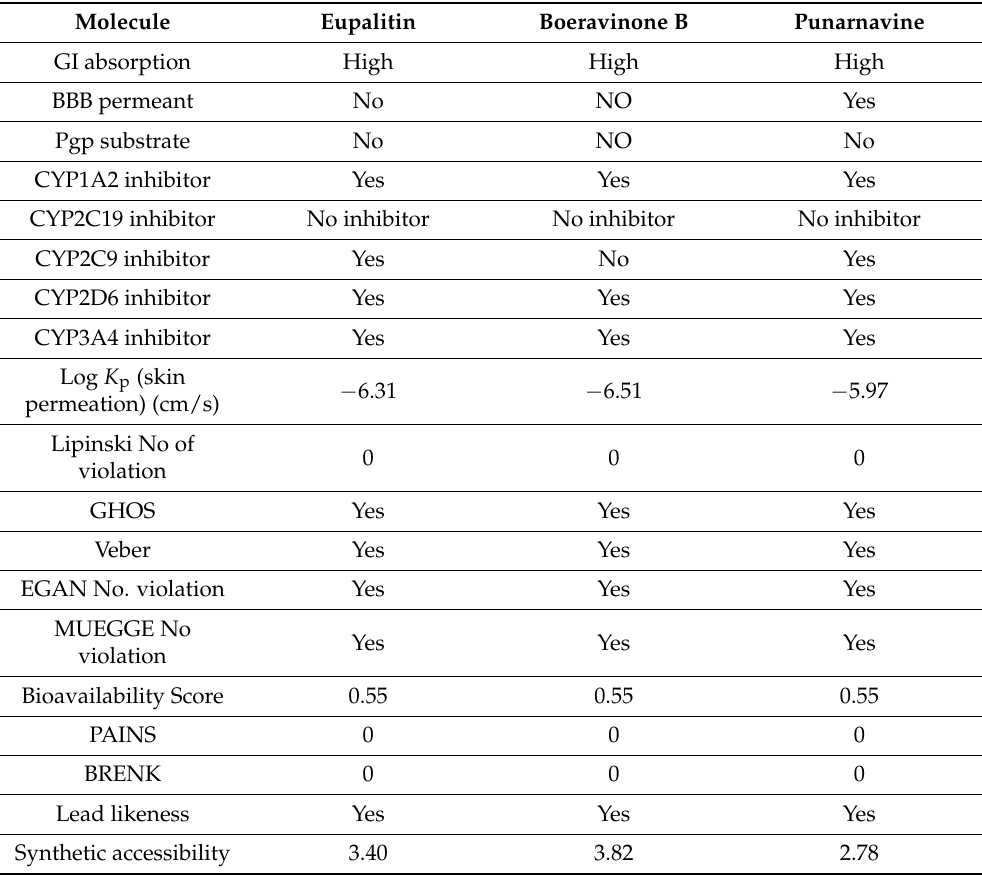
Table 3. Pharmacokinetics profile of the selected bioactive